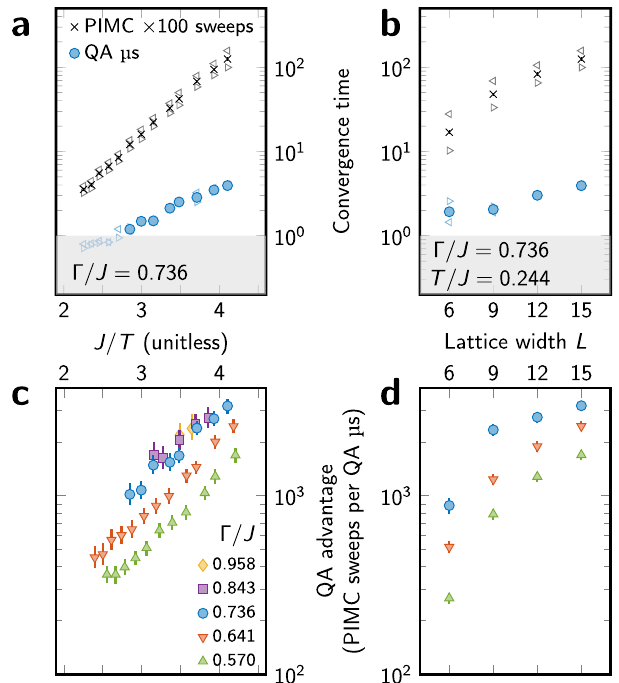
Fig. 4 Scaling of convergence time and QA speedup. a , b Convergence time for both QA and PIMC as a function of inverse temperature J / T ( a ) and lattice width L ( b ). Triangles ⊲ and ⊳ indicate times for CCW and CW initial states, respectively; other markers indicate geometric mean. QA data are discarded if the estimate of m h i is not accurate to within 0.03, or either CCW or CW convergence time is <1 μ s (shaded region). c , d QA advantage over PIMC, given as the ratio of convergence times, increases as T decreases ( c ), as quantum fl uctuations increase ( c ), and as system size increases ( d ). Temperatures shown in d are minimum for which QA results are accurate ( J / T ≈ 4.2 in each case). Scaling in L ( b , d ) is given in terms of PIMC sweeps to show equilibration dynamics rather than computation time. All fi lled data points have 95% CI bootstrap error bars, often smaller than the marker. At Γ / J = 0.736, T / J = 0.244, QA equilibration is three million times faster than PIMC on a CPU (Supplementary